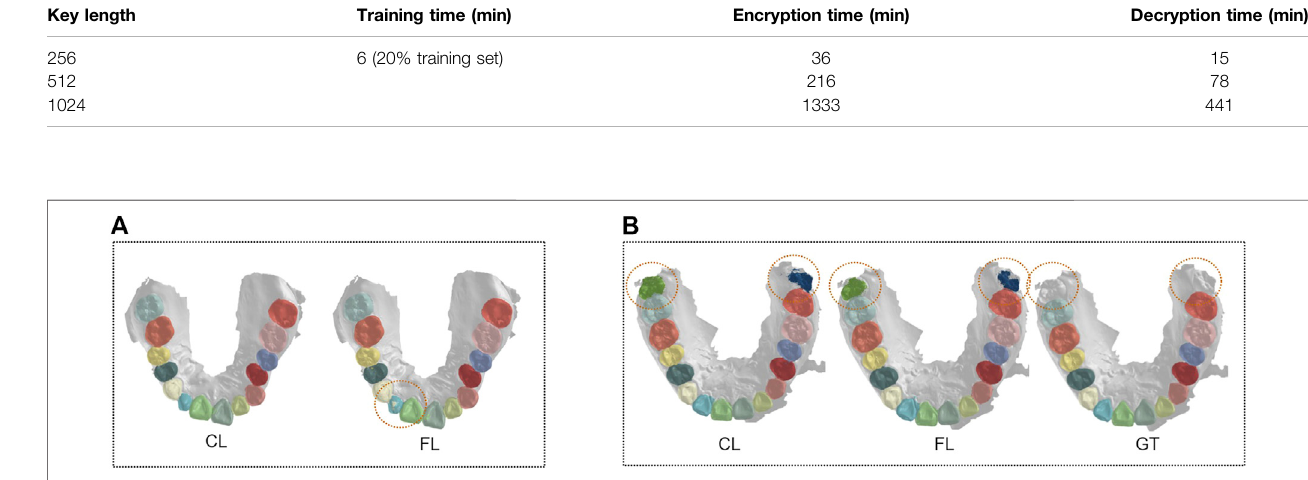
Frontiers in Communications and Networks |